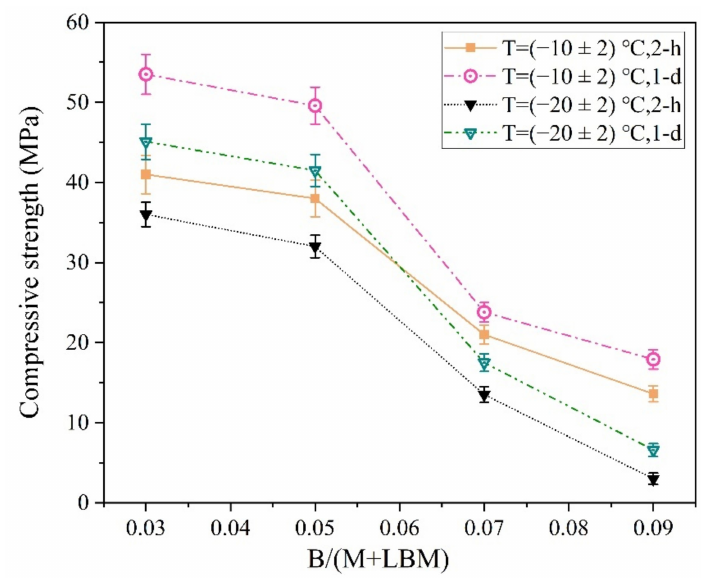
Figure 14. The influence of the B / (M + LBM) ratio on the early strength of the